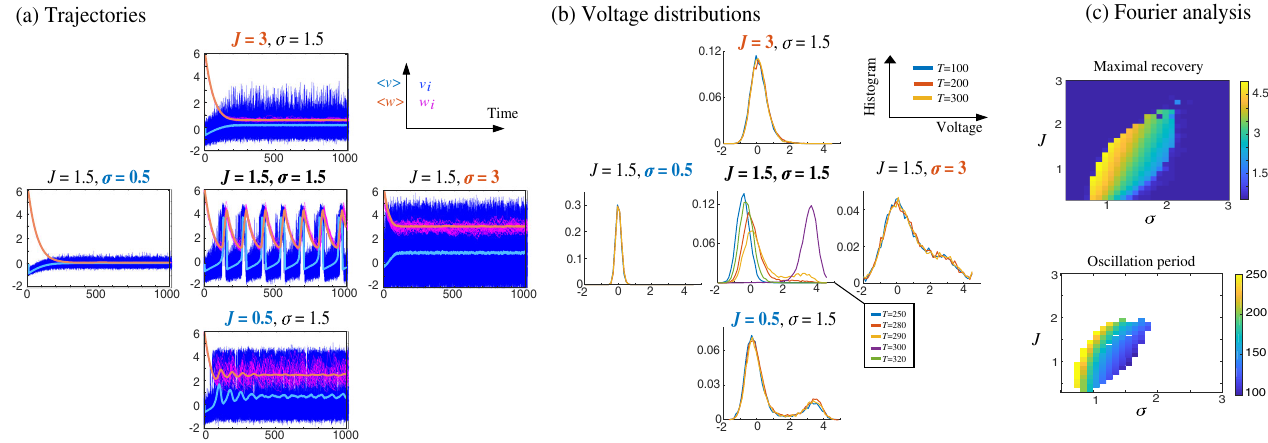
(c) Fourier analysis(b) Voltage distributions